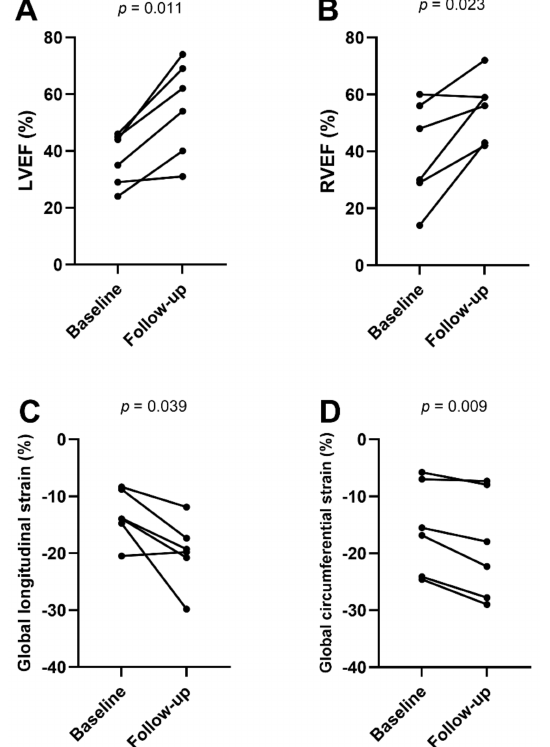
Figure 2. Line graphs show functional cardiac magnetic resonance parameters ( A – D ) at baseline ( n = 6) and follow-up ( n = 6). Individual values are represented by the dots at baseline and follow-up MRI. The connecting lines show the tendency of change in functional parameters over time. p -Values were obtained using paired Student’s t -test. LVEF = left ventricular ejection fraction, RVEF = right ventricular ejection fraction.